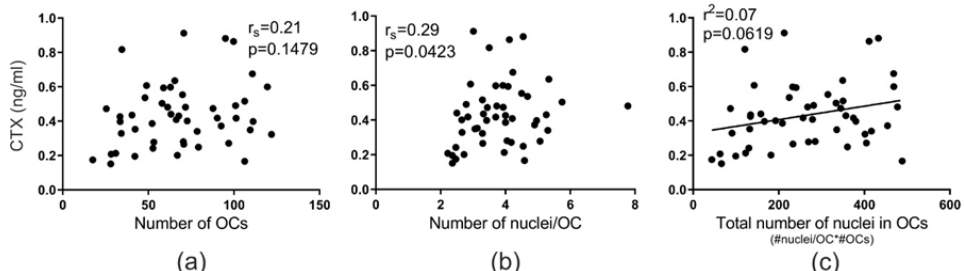
Figure 3. Fusion potential of OCs in vitro reflects in vivo bone resorption levels of their donor. The relation between CTX level in vivo and ( a ) the mean number of OCs (per vision field), ( b ) the mean number of nuclei per OC, and ( c ) the total number of nuclei in OCs (per vision field). Statistics: correlation analyses were performed using either Spearman’s rank correlation (r s ) in ( a , b ) or Pearson’s correlation (r 2 ) in ( c ). Each point represents the results obtained from OCs in vitro generated from an individual donor ( n = 49). “#”, number; “*”, multiplied by.